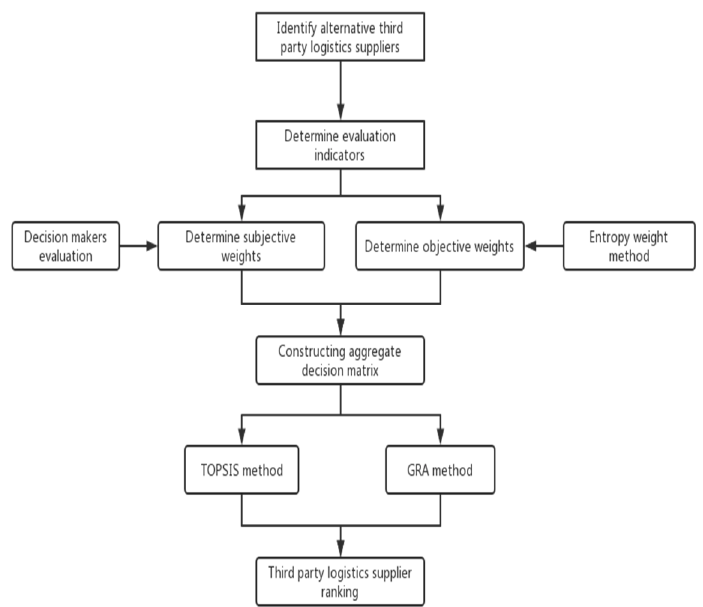
Figure 1. Flow chart of proposed methodology.